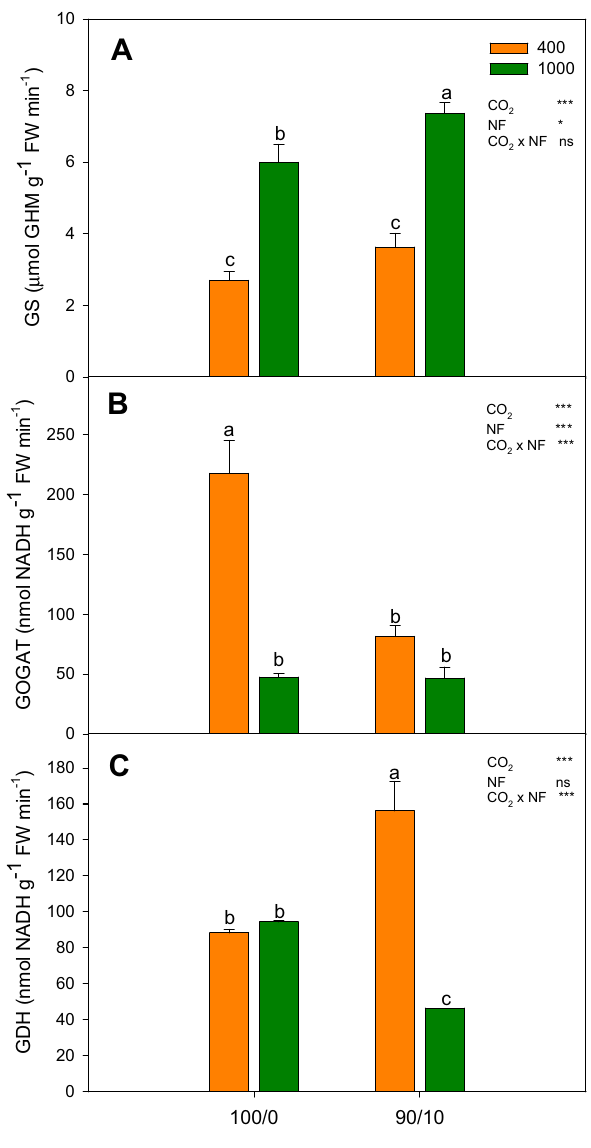
Figure 3. Effect of N forms (100% NO 3 − and 90% NO 3 − /10% NH 4 + combined) under an elevated CO 2 concentration on leaves of cucumber: ( A ) glutamine synthetase activity (GS); ( B ) glutamate synthase activity (GOGAT); and ( C ) glutamate dehydrogenase activity (GDH). Data are means ± SE of six plants. Data are means ± SE of six plants. Different letters indicate significant ( P ≤ 0.05) differences between